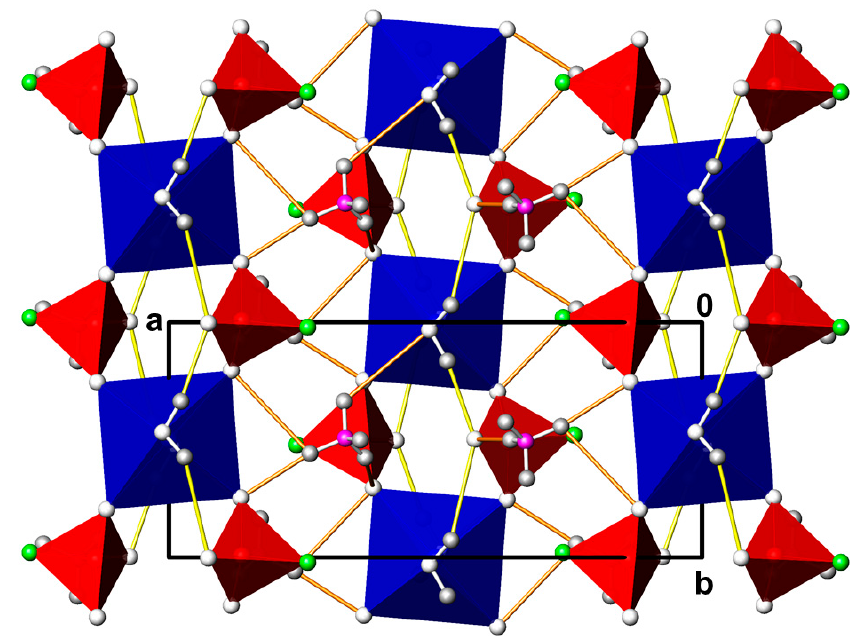
Figure 7. The crystal structure of (NH 4 ) 2 Mn(PO 3 F) 2 (H 2 O) 2 in a projection along [001]. Colour code as in Figure